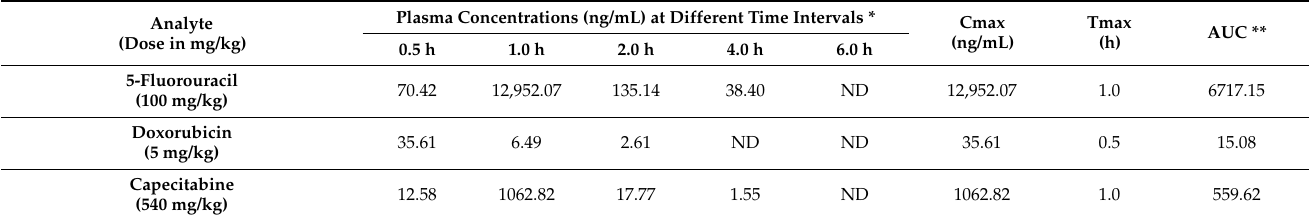
Table 5. Concentrations of the investigated drugs in plasma samples collected from male rats following intraperitoneal injection of a single dose of anticancer combination ( n = 7). Analyte (Dose in mg/kg)